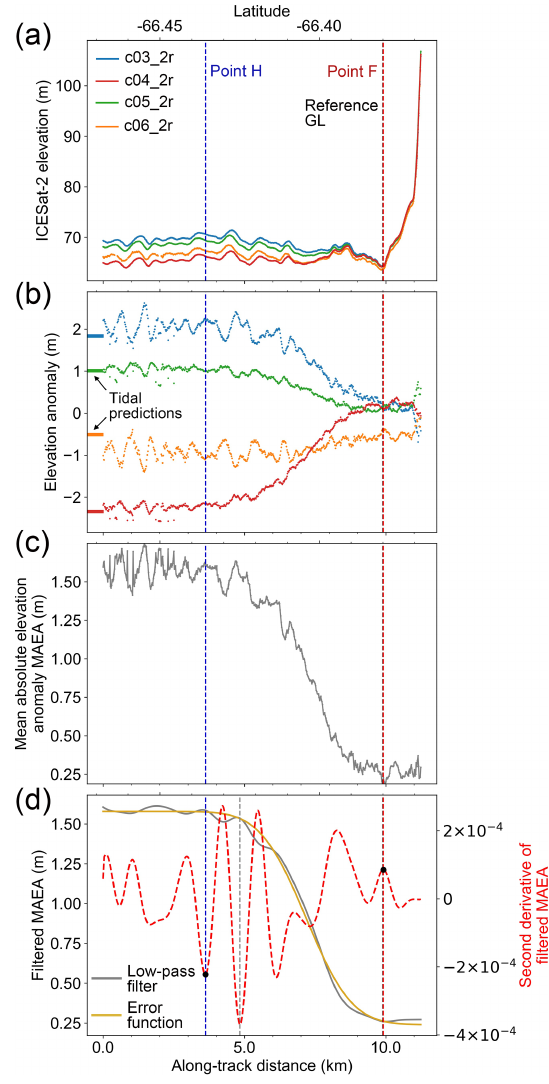
Figure 5. ICESat-2 repeat-track analysis for four right beams from repeat cycles 3–6 in beam pair 2 of track 1009. The location of track 1009 beam pair 2 is shown in Fig. 2. (a) ICESat-2 “re-tided” elevation profiles. c03_2r in the legend refers to the right beam of beam pair 2 in repeat cycle 3. (b) The elevation anomalies of each repeat track. Horizontal lines at the left are the zero mean tide height predictions from the CATS2008 tidal model (Padman et al., 2002) following Fricker and Padman (2006). (c) The mean absolute ele- vation anomaly (MAEA). (d) Low-pass-filtered MAEA is shown as a grey solid line, error function fitting of the MAEA is shown as a yellow solid line, the second derivate of low-pass-filtered MAEA is shown as a red dashed curve, the black dots are the locations of the inland limit of tidal flexure Point F (right) and inland limit of hydrostatic equilibrium Point H (left), and the vertical dashed grey line is the location of Point H when using the third derivate of the error function as the guide point. Locations of the Point F, Point H, and reference grounding line (GL) are marked as the vertical dashed red line, vertical dashed blue line, and vertical dashed black line in all